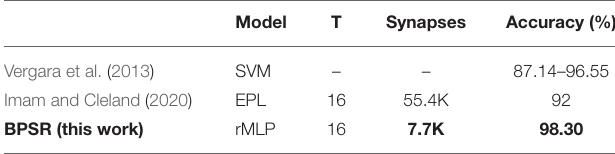
TABLE 7 | Comparison of different models on gas senor